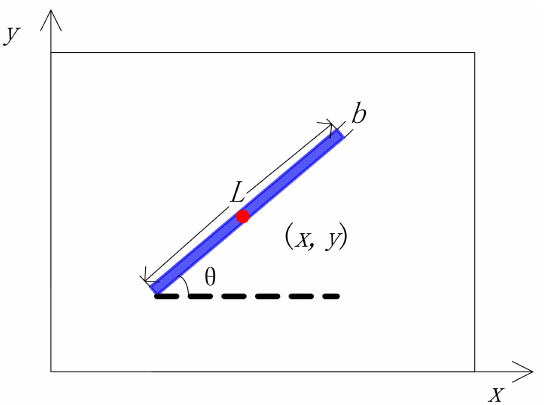
Figure 3. The parameters of a fracture are the coordinates of midpoint ( x , y ), length L , dip angle θ , and fracture aperture b